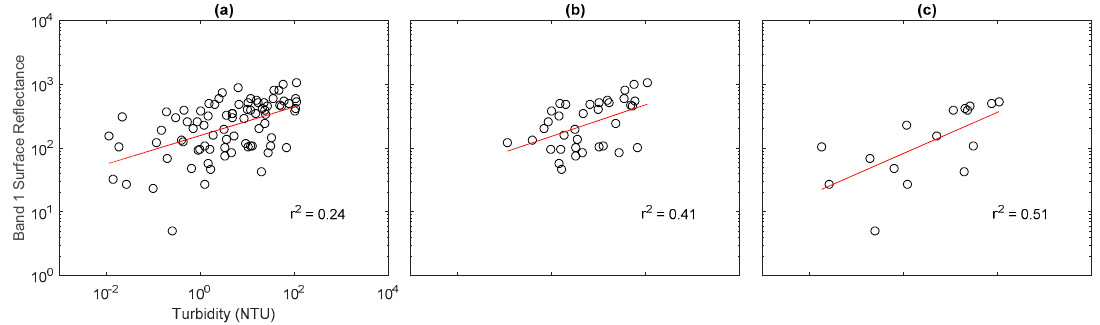
Figure 3. The log–log relationship between in situ measurements of turbidity and MODIS Band 1 surface reflectance for ( a ) all matchups, ( b ) on the same day as the rainfall event and ( c ) one day after a rainfall event. The linear relationships ( r 2 ) of 0.298, 0.43 and 0.60 were slightly more robust.